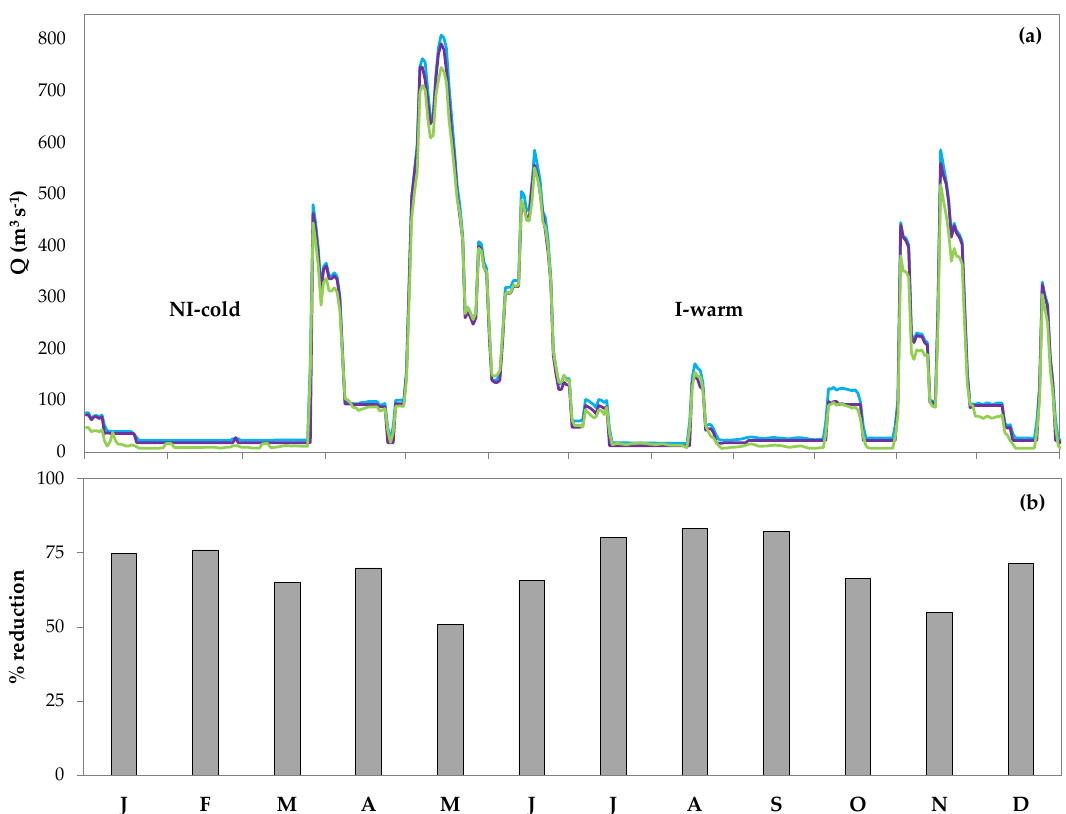
Figure 3. ( a ) Mean daily streamflows of the Ticino River at the three study sites downstream of water withdrawals (IF1 = blue line, MF1 = purple line, MF2 = green line) of a typical year during the study period (2010). ( b ) Monthly averaged streamflow reduction (%) at MF1 compared to the lake outflow, calculated over the period 2010–2015. NI-cold = Non-Irrigation-cold period of low flows, I-warm = Irrigation-warm period of low flows.